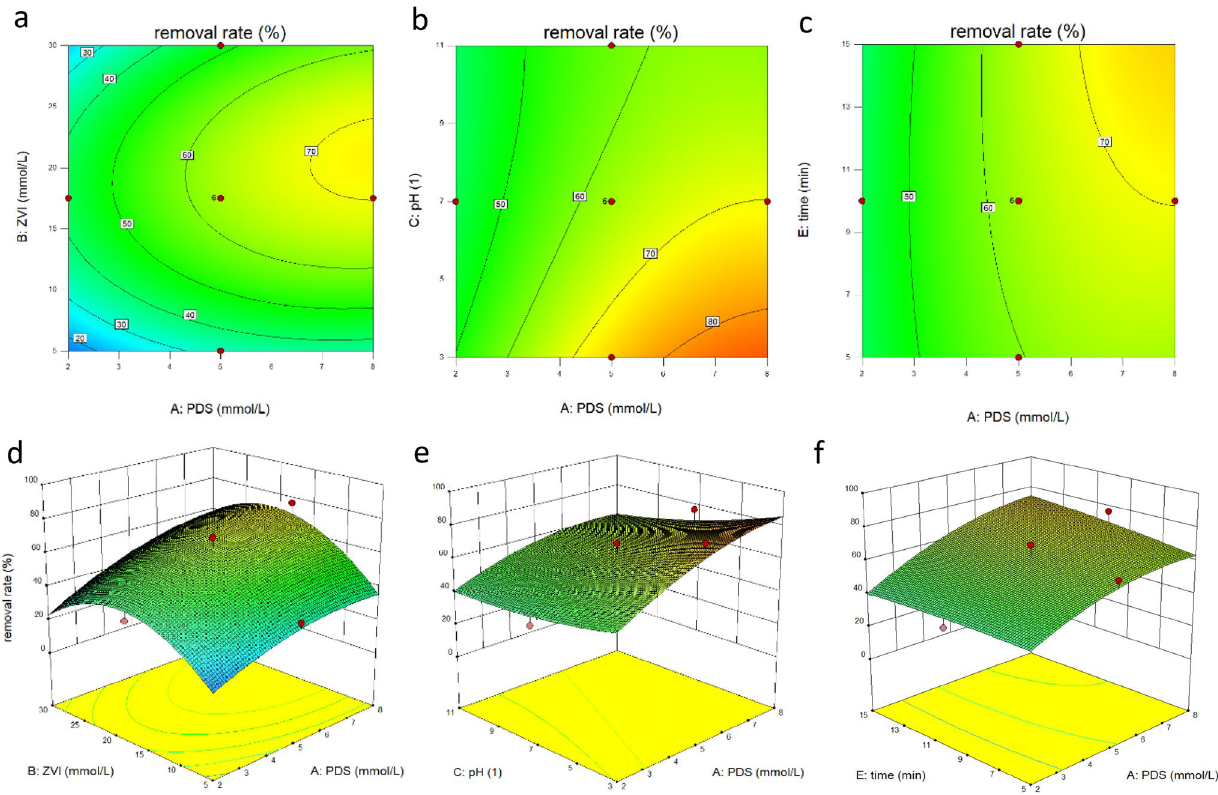
Fig. 8 2D contour and 3D plots of the interactions between different parameters: PDS and ZVI ( a , d ), PDS and pH ( b , e ), PDS and reaction time ( c , f )